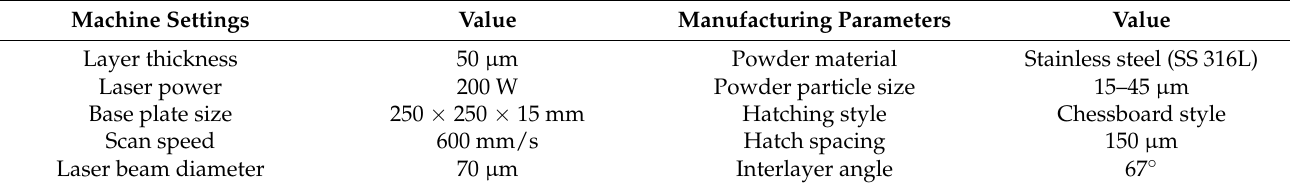
Table 2. Machine parameters and manufacturing parameters for the experimentation.